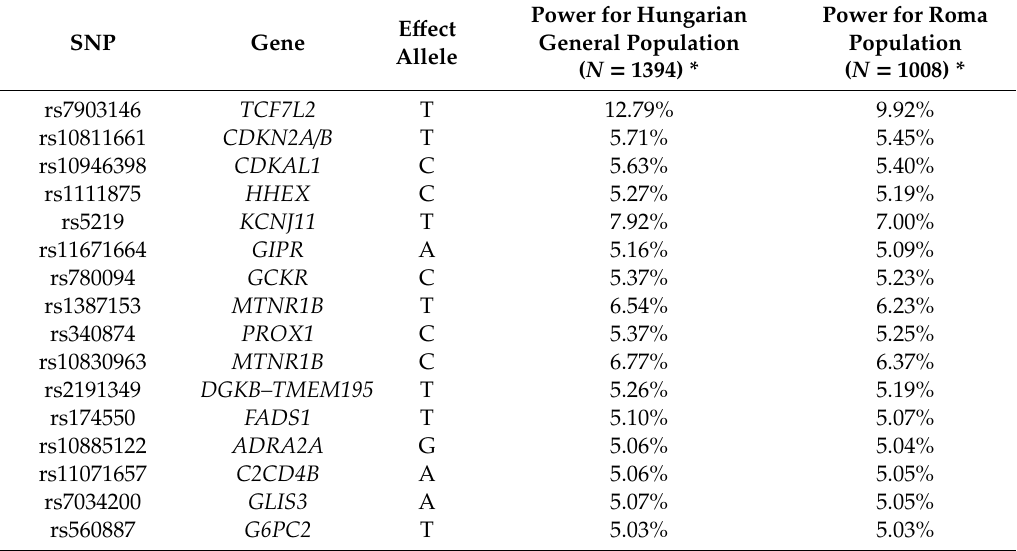
Table 3. Statistical power of the susceptible alleles considered separately for study